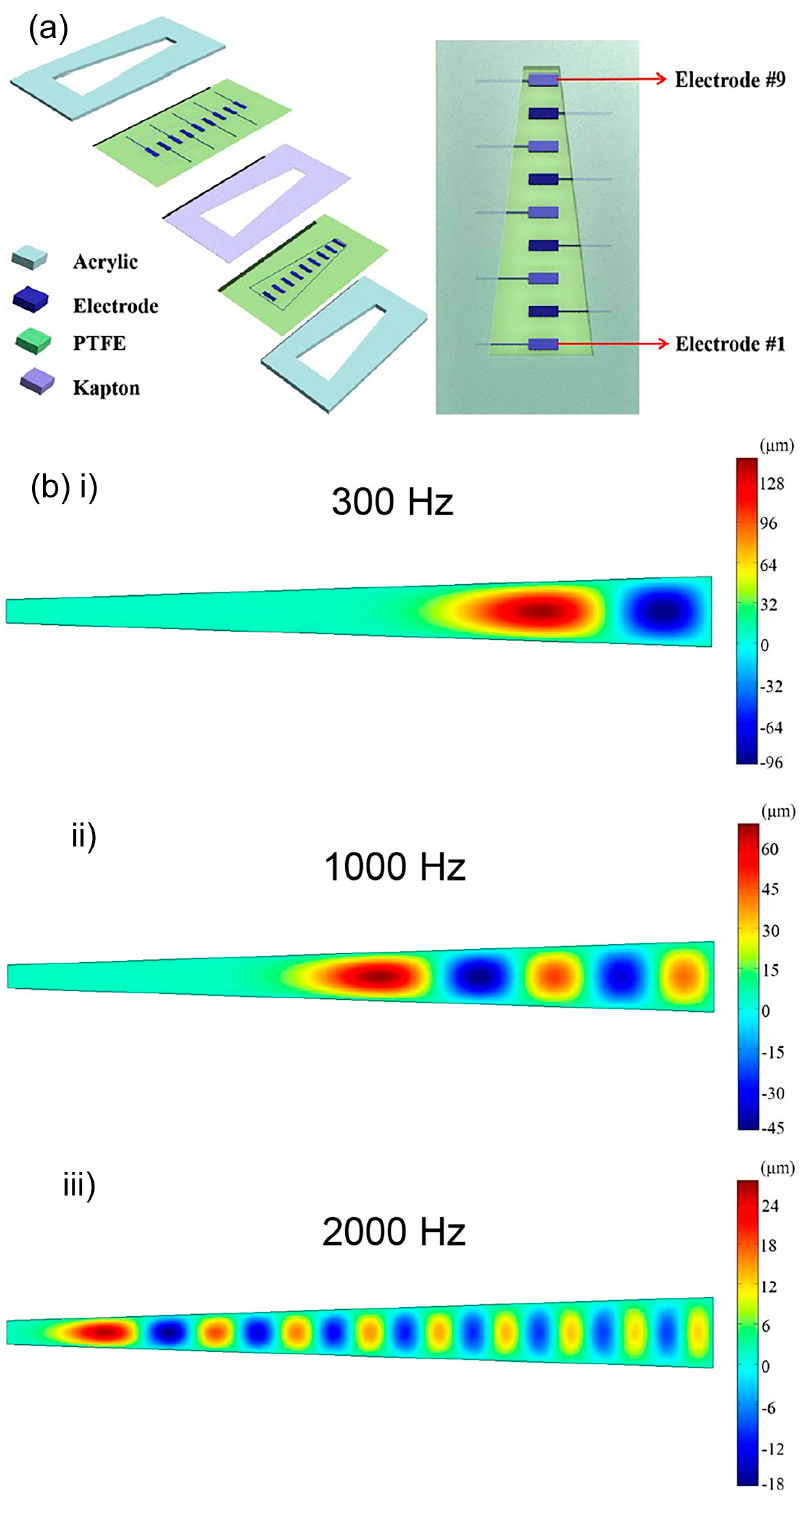
Figure 17. ( a ) The structural design of bionic acoustic triboelectric-based sensor. Two rectangular acrylic plates with trapezoidal cavity are used as the frames to support the PTFE membranes. The silver electrodes are numbered from electrode #1 to #9. ( b ) The simulated vibration characteristics of a trapezoidal PTFE membrane at 300 Hz, 1000 Hz and 2000 Hz of frequency input [76]. The Kapton film’s thickness will determine the sound pressure detection limit and both Kapton film and PTFE membranes are strain-free. The trapezoid-shaped membrane is quite big with 10–30 mm width and 20 µm thickness. The acoustic vibration of PTFE membranes induces electricity generation. The triboelectric voltage output demonstrates a linear relationship with sound pressure. The device works within 20 Hz to 3000 Hz of